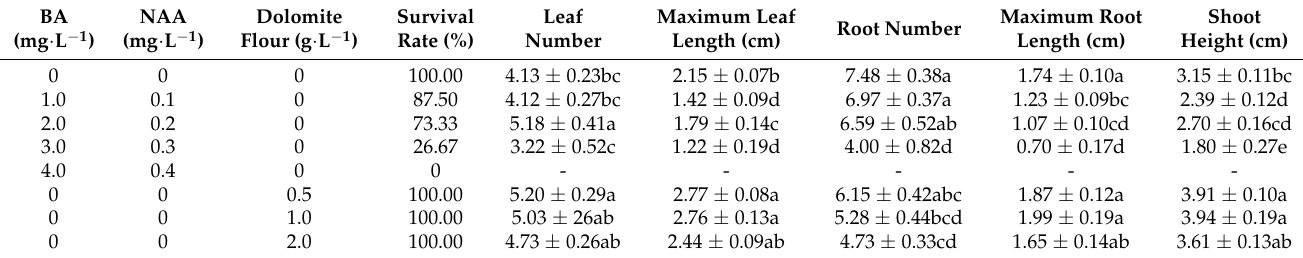
Table 8. Effect of plant growth regulators and dolomite flour on the seedling growth of Paphiopedilum tigrinum . BA (mg · L − 1